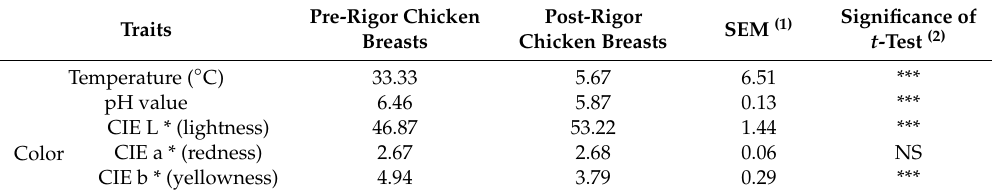
Table 1. Temperature, pH value, and color characteristics of intact pre- and post-rigor chicken breasts. Traits